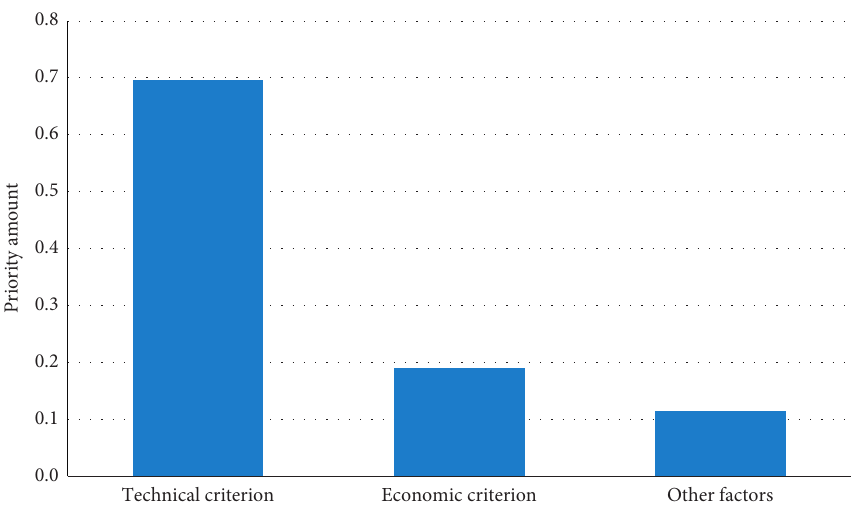
Figure 5: Representation of the priority of the main criteria in the research. Table 5: Prioritizing the technical subcriteria.